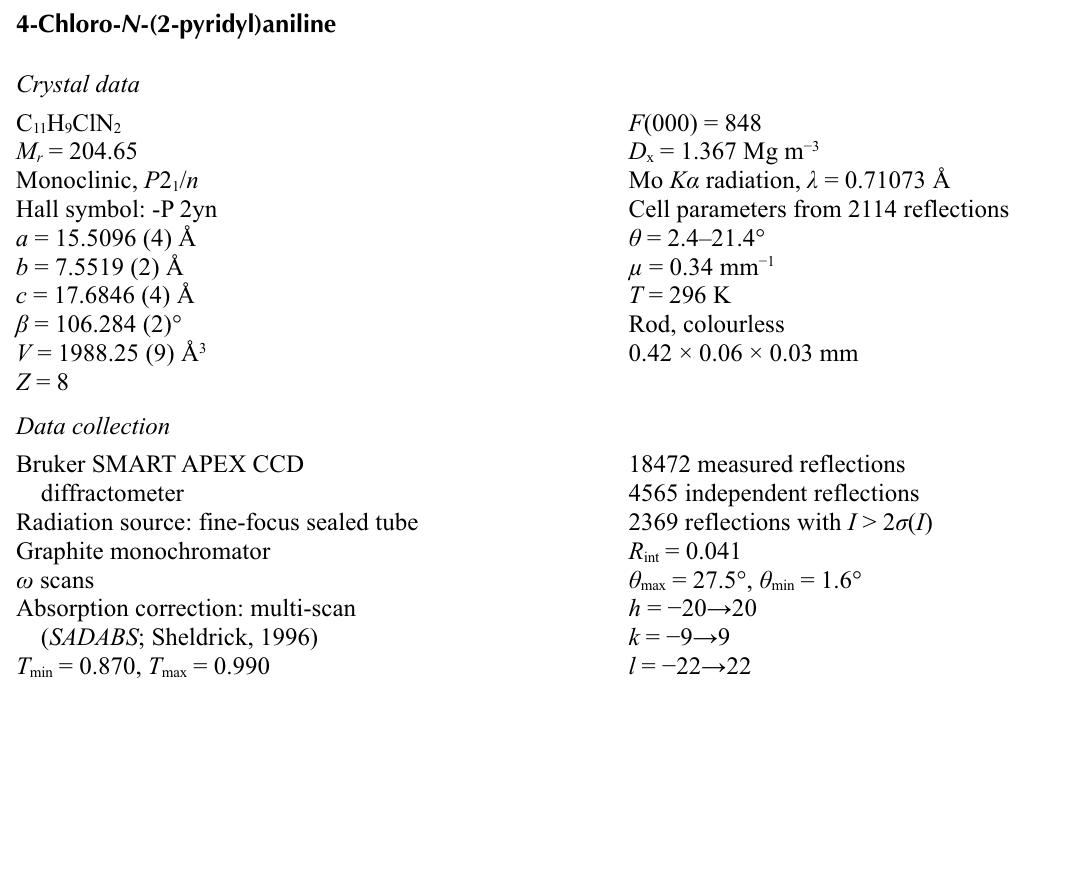
Figure 1 The molecular structure of (I) drawn at the 70% probability level; hydrogen atoms are drawn as spheres of arbitrary